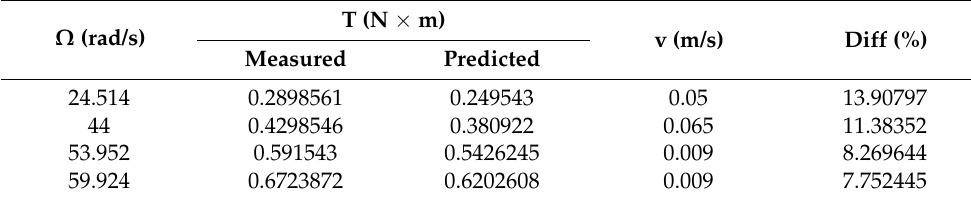
Table 3. Validation set of data using different values of the rotation rate.